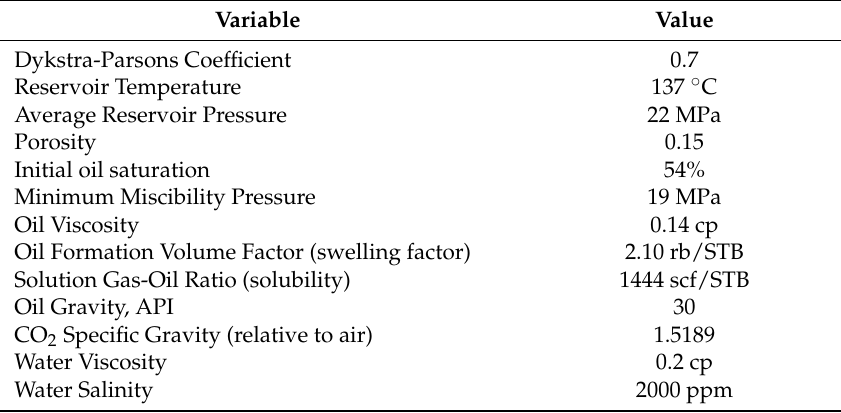
Figure 5. The selected model grid block with injection and production well locations. Table 2. Model parameters [47].